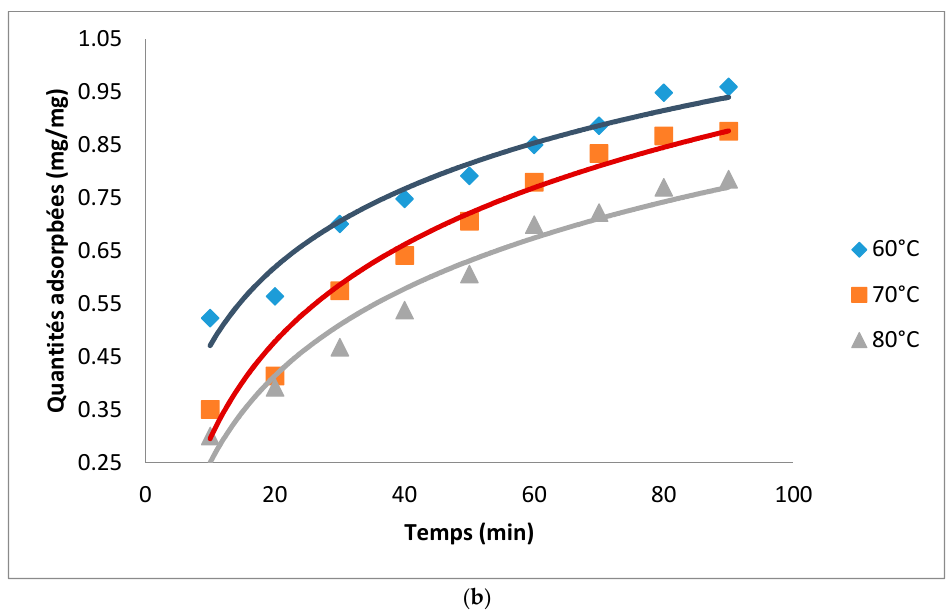
Figure 2. ( a ) Adsorption kinetics for the decolorization of cotton seed oil using AC from cotton; ( b ) Adsorption kinetics for the decolorization of cotton seed oil using AC from neem.